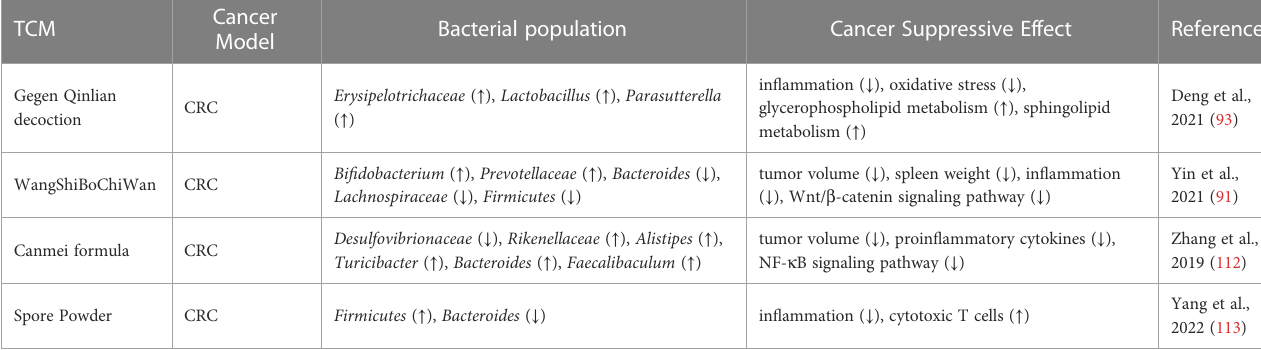
TABLE 2 TCM improves immunotherapy by modulating intestinal